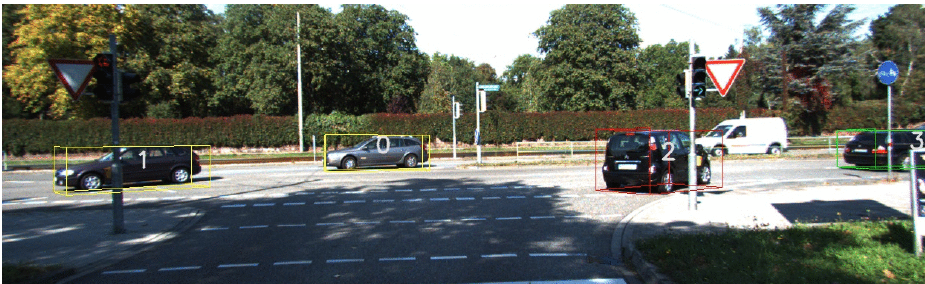
Figure 1. Object tracking with 3D bounding boxes and tracking